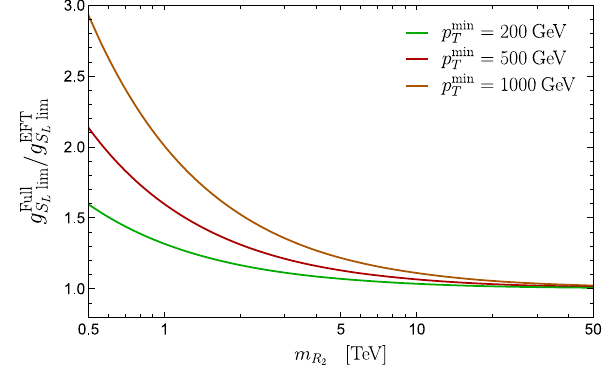
Fig. 2 Ratio of the limits obtained with the full model and the EFT for various p T cuts, in the limit of infinite luminosity larger values of p min T